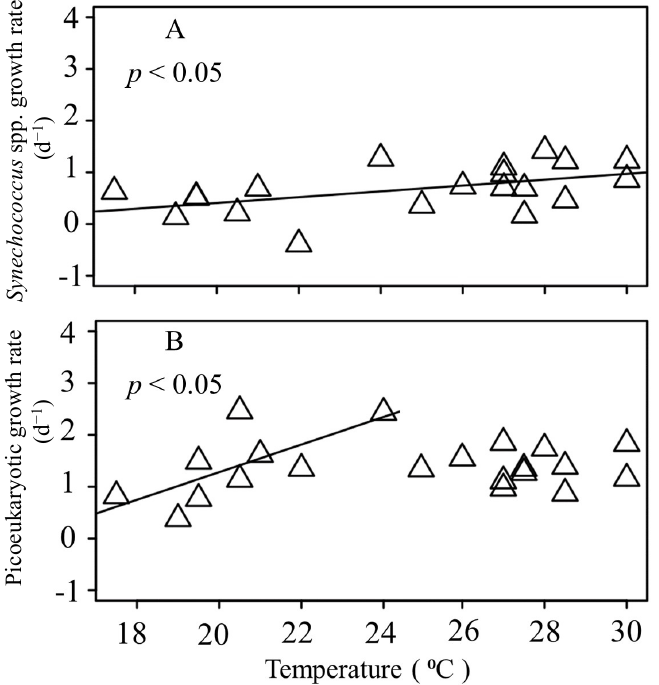
Figure 6. Relationship between Synechococcus spp. ( A ) and picoeukaryotic gross growth rates ( B ) and sea surface water temperature. Solid lines exhibit the fitted linear regressions.